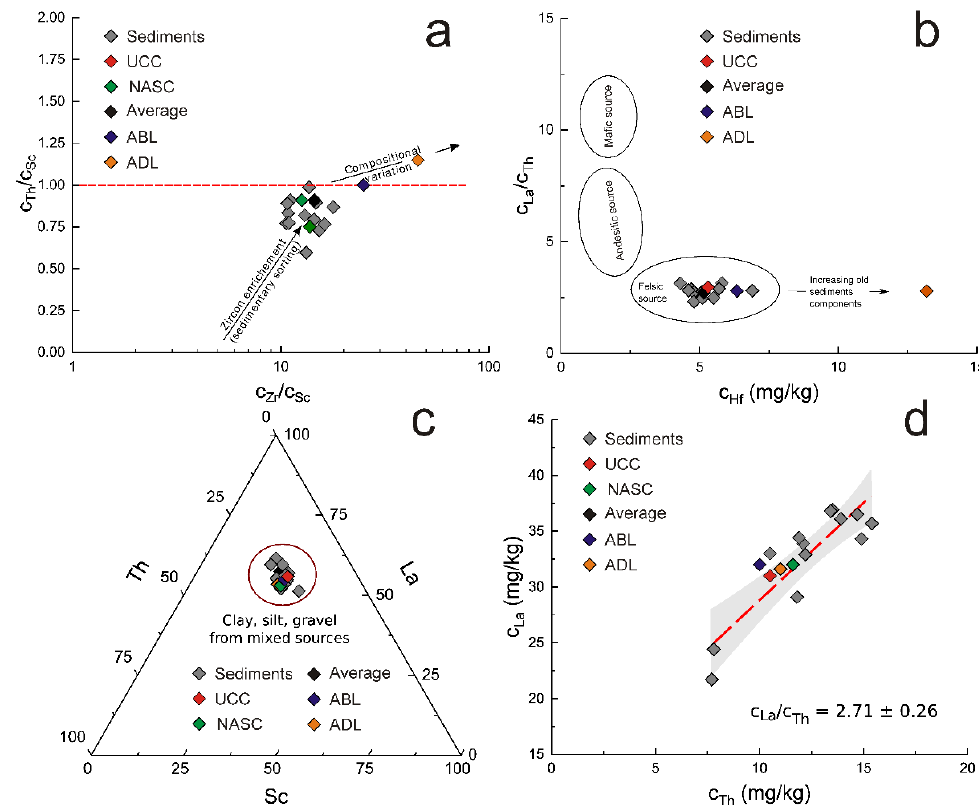
Figure 6. The discriminating Th/Sc vs. Zr/Sc ( a ), La/Th vs. Hf ( b ) biplots, ternary plot Sc-La-Th ( c ), and La vs. Th biplot ( d ) .